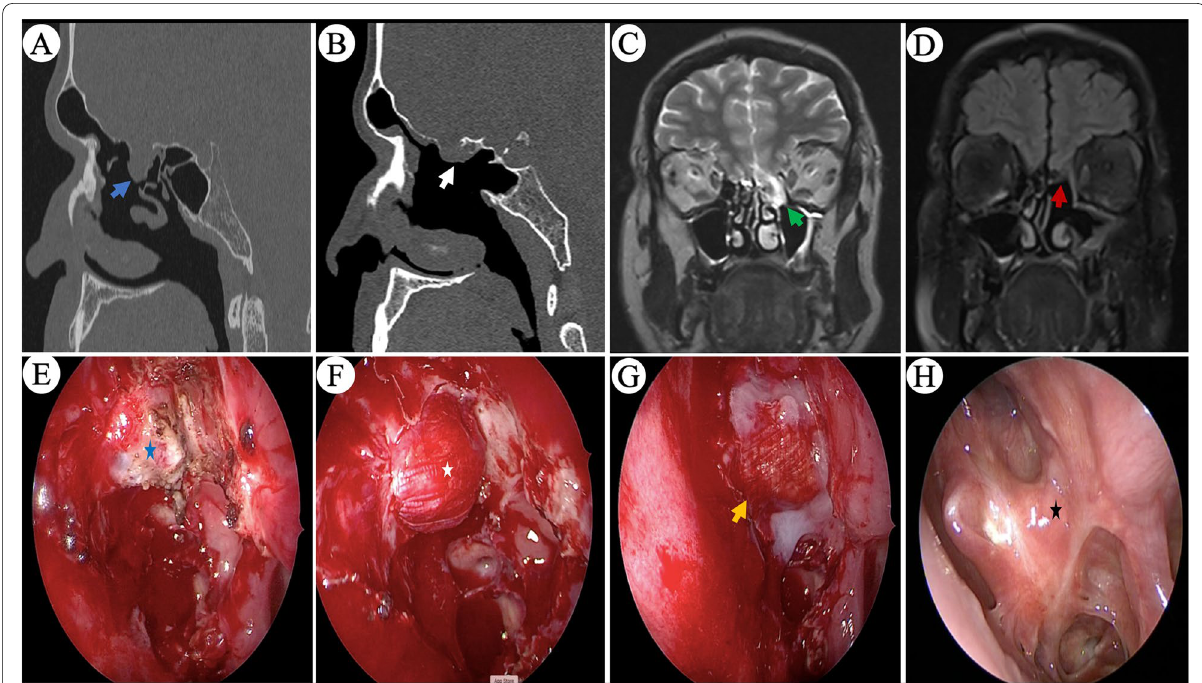
Fig. 2 Demonstrate a multilayer technique utilizing fascia lata and middle turbinate grafts. A Preoperative CT scan image (sagittal view) shows a defect marked by blue arrow. B Postoperative CT scan image (sagittal view) shows the repair site marked by white arrow. C T2-weighted MRI (coronal view), green arrow denoted the skull base defect site at level of posterior ethmoid sinuses. D Postoperative T2 flair MRI (coronal view) shows the repair site marked by red arrow. E Intraoperative endoscopic image shows the defect site marked by blue asterisk. F First layer (inlay) of the repair using fascia lata marked by white asterisk. H Second layer using fascia lata as (overlay) sealed with fibrin glue marked with yellow arrow. G Six months postoperative endoscopic image shows the healed defect site denoted by black